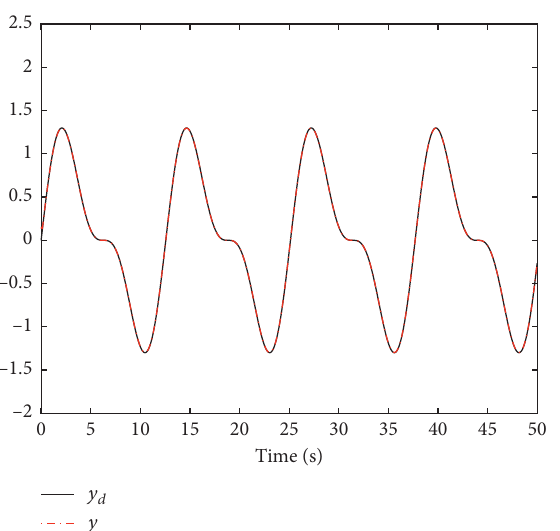
Figure 8: State variables x